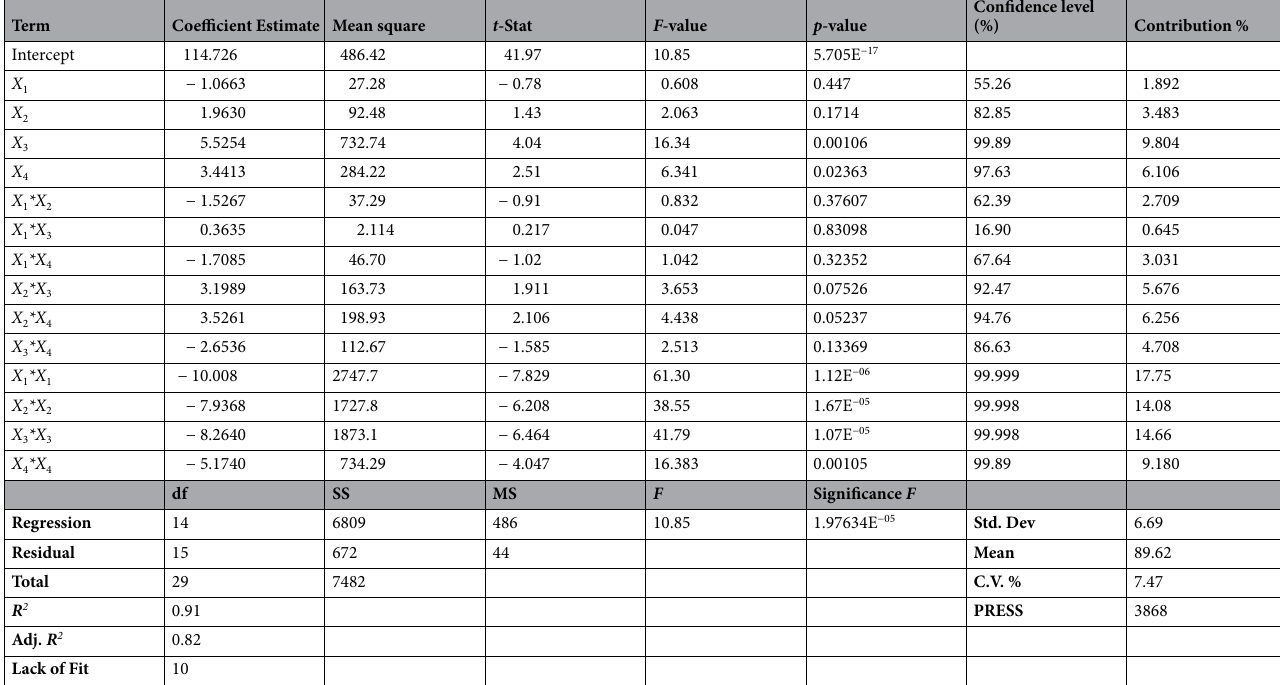
Table 4. Analysis of variance for the response surface of ACP production by B. haynesii strain ACP1 obtained by RCCD. “Std. Dev. is the standard deviation, the coefficient of determination ( R 2 ), Adj R 2 is the adjusted- R 2 , and PRESS is the prediction error sum of squares, C.V is the Coefficient of